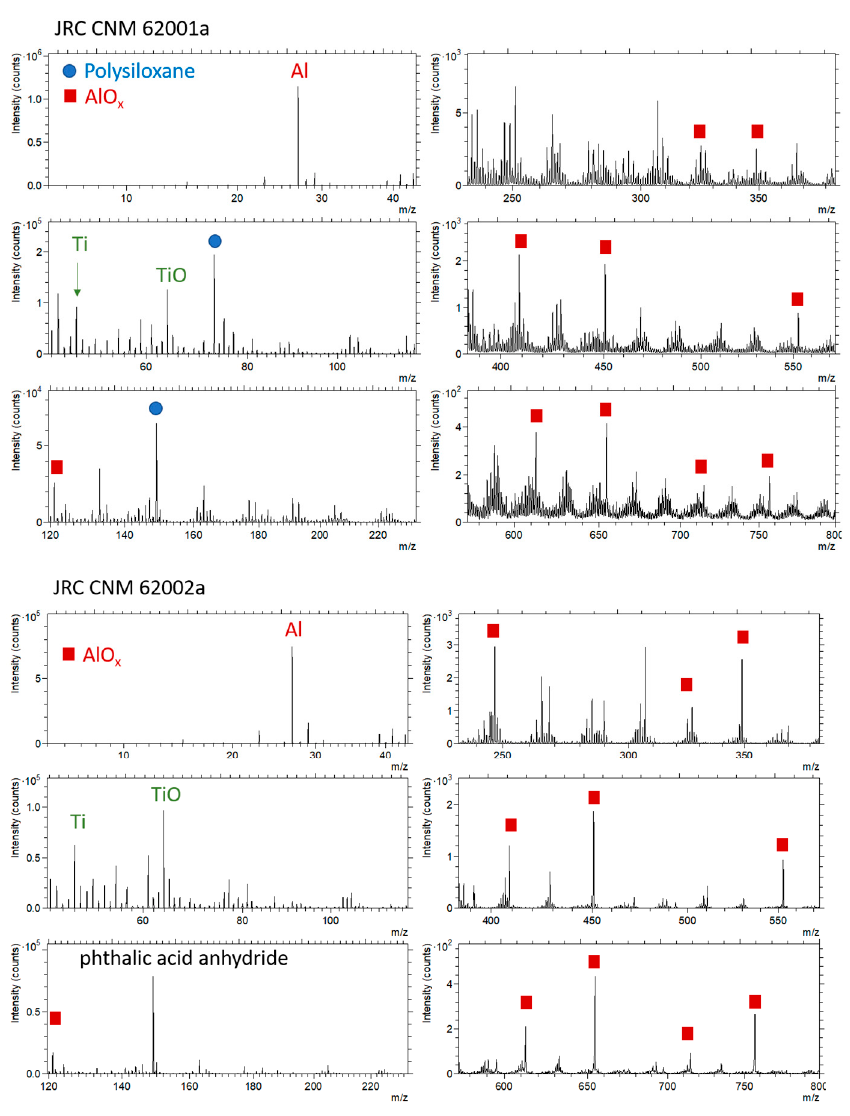
Figure 7. ToF-SIMS spectra, positively charged secondary ions (top: JRCNM 62001a, bottom, JRCNM 62002a); field of view: 325 × 325 µm².